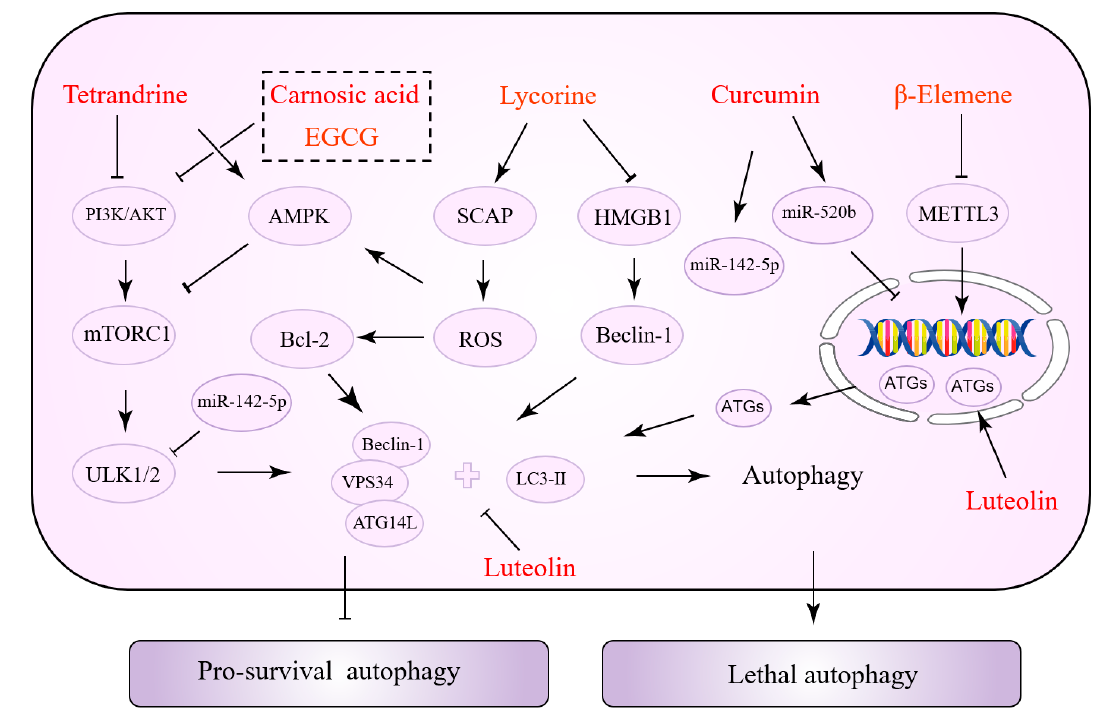
Figure 3. Natural products with a dual role in autophagy regulation. Tetrandrine (TET) has been shown to exert anti-cancer properties via targeting au- tophagy, according to a recent review [125]. TET induces autophagy in tumor cells by increasing the accumulation of ROS. Specifically, ROS activates ERK/MAPK and promotes the transcription of ATG7, thus promoting autophagy [126,127]. Furthermore, autophagy and apoptosis induced by TET-stimulated ROS accumulation may be controlled by caspase-3, which mediates apoptosis via interacting with p21, but not by AKT activity [128]. TET, on the other hand, can inhibit mTOR and induce autophagy by acting as a protein kinase C (PKC) inhibitor. This signaling pathway is not dependent on ROS [129]. TET promotes autophagy, which improves chemotherapeutic drug susceptibility. In NSCLC, TET and cisplatin decrease PI3K/AKT activity and Bcl-2 expression, which are important regulators of cellular autophagy inhibition [130]. In addition to the PI3K/AKT pathway, TET enhanced autophagy by downregulating the protein expression of survivin (one of the most potent anti-apoptotic suppressor genes). In turn, it reverses GEM resistance and promotes apopto- sis in drug-resistant PANC-1 cells [131]. Tamoxifen (TMX) is an anti-estrogenic medication used to treat some types of breast and endometrial cancer. Wang et al. demonstrated that TET increases TMX sensitivity. In vitro experiments revealed that autophagy inhibition could be a mechanism for TET to overcome tamoxifen resistance [132]. Epidermal growth factor receptor-tyrosine kinase inhibitors (EGFR-TKIs) such as gefitinib, erlotinib, and afatinib are routinely used to treat patients with lung adenocarcinoma. However, the development of acquired drug resistance impacts the overall therapy result. By blocking lysosomes, TET improves the susceptibility of gefitinib in human lung cancer cells [133]. As previously stated, TET’s control of autophagy may be the opposite in different malignancies and drug resistance states.